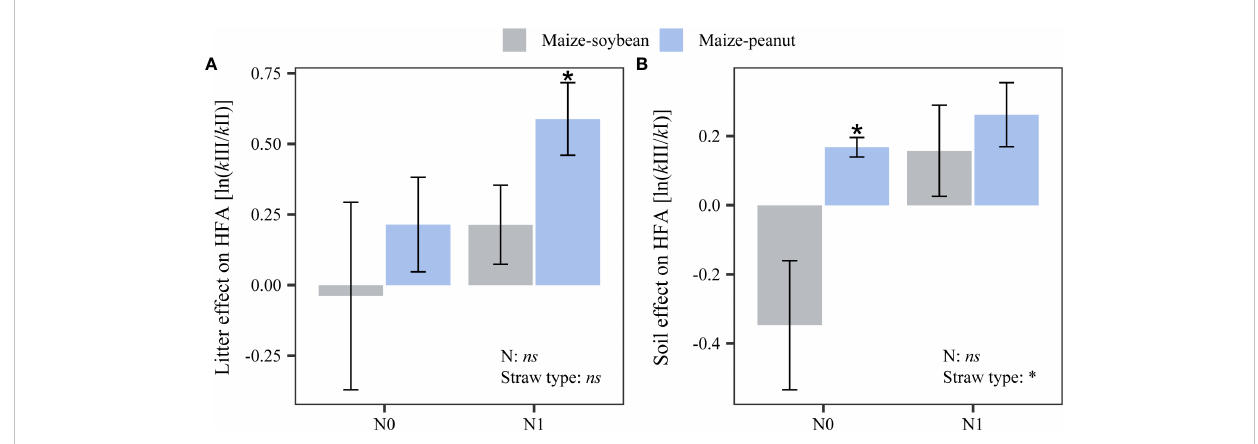
FIGURE 3 Effects of nitrogen addition and straw type on the home- fi eld advantage effect via (A) litter type ( ‘ litter effect ’ ) and (B) soil environment ( ‘ soil effect ’ ). Asterisks above bars indicate signi fi cant differences between the home- fi eld advantage effect and zero ( P < 0.05). Statistical signi fi cance of the main effects of nitrogen application and straw type on HFA was also shown (* P < 0.05, ns : not signi fi cant).. Data are mean ± SE ( n